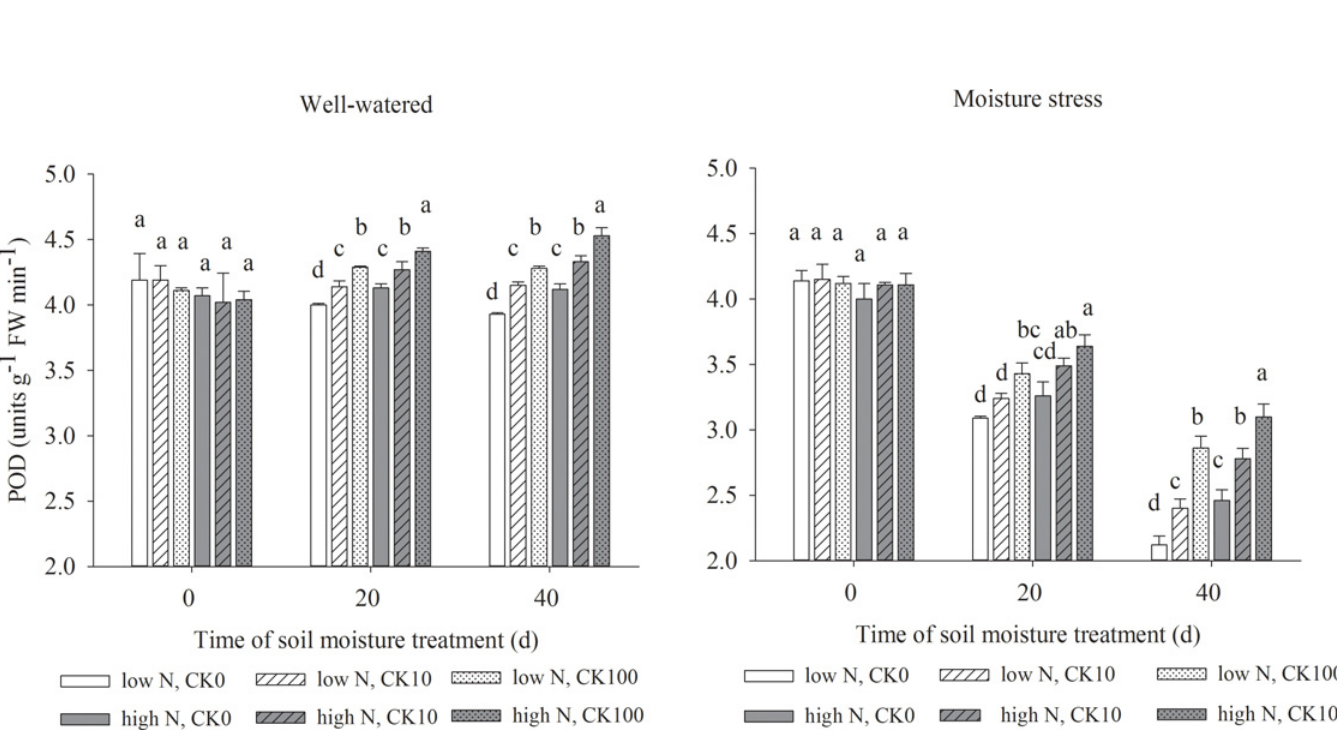
PLOS ONE | DOI:10.1371/journal.pone.0154005 April 21,